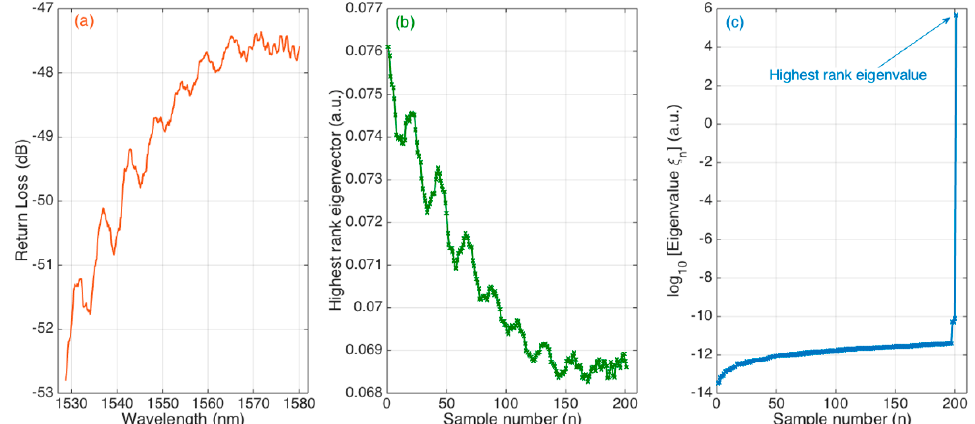
Figure 4. Overview of the operation of the undersampled KLT applied to the spectrum of a ball resonator. ( a ) The reflection spectrum of the ball resonator, acquired by the OBR and processed. ( b ) The eigenvector corresponding to the highest rank eigenvalue, acquired over 201 samples. ( c ) Eigenvalue string, reporting the magnitude (in logarithmic units) of all 201 eigenvalues sorted in ascending order.